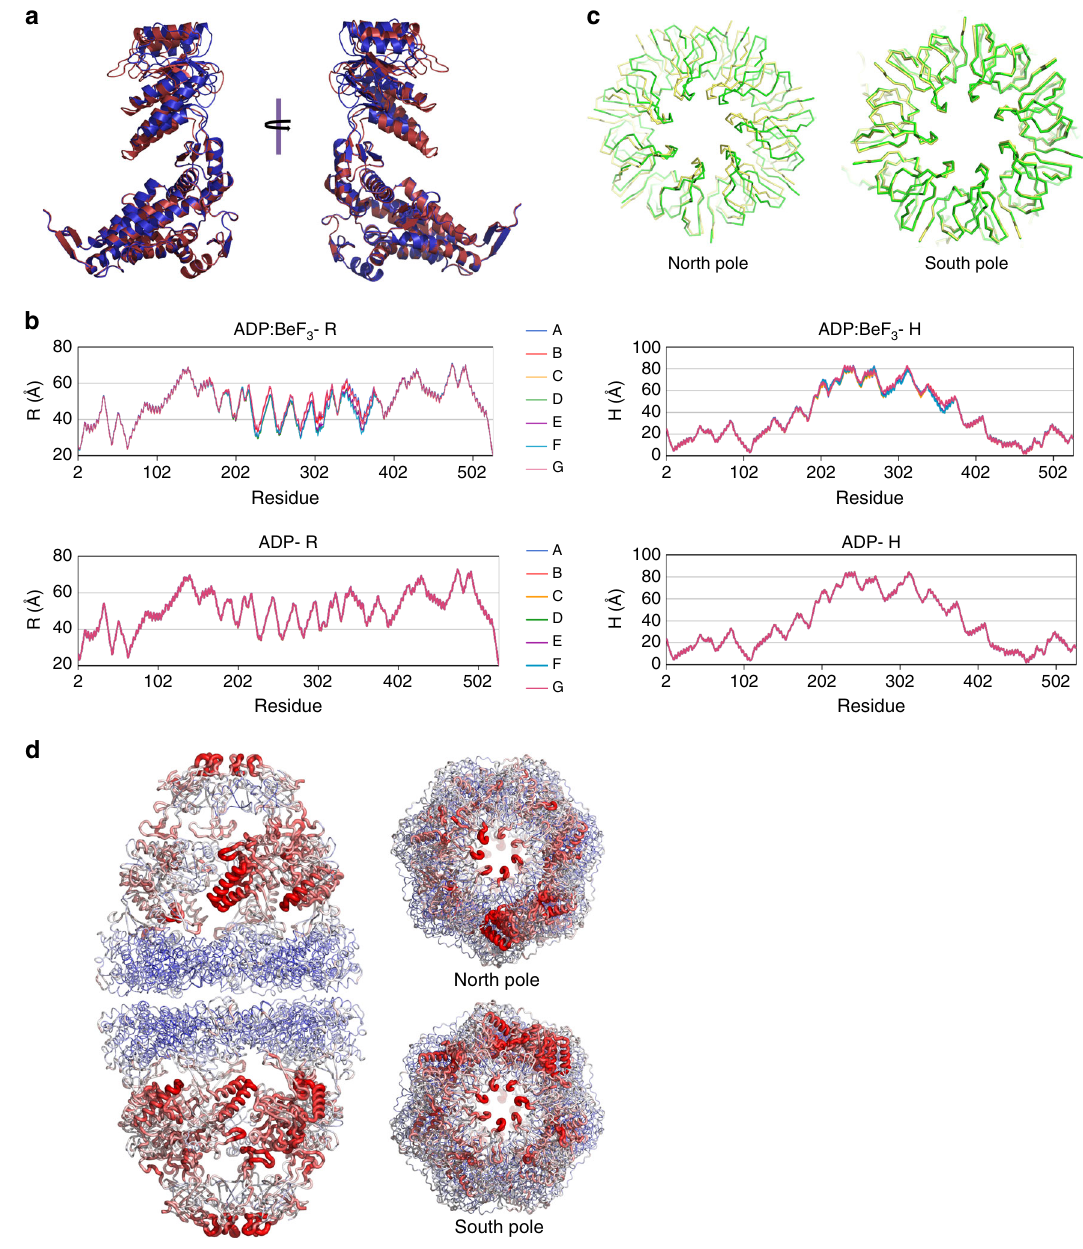
Fig. 3 Transition from the ATP ground-state mimic to ADP football. a Superposition of the two most conformationally divergent mHsp60 subunits from the ADP:BeF 3 -bound football complex shows signi fi cant backbone conformational asymmetry. The two perspectives depicted are related by 180° rotation. b The crystal structure of the ADP:BeF 3 -bound football complex and the structure of the ADP-bound football complex built from the C1 cryo-EM map were subjected to a conformational analysis using a cylindrical coordinate system previously employed to analyze the conformation of individual subunits in GroEL 36,37 . In this analysis, R is the distance between the C α of a given residue and the sevenfold symmetry axis, whereas H is de fi ned as the height of the C α of a given residue over the twofold plane of symmetry between two rings. Each trace represents one mHsp60 subunit within the same ring. From top to bottom: ADP:BeF 3 – R: radial distance to the longitudinal axis for the ADP:BeF 3 -bound football complex crystal structure; ADP – R: radial distance for the ADP-bound football complex C1 cryo-EM structure; ADP:BeF 3 – H: height from the equator of the complex for the ADP:BeF 3 -bound football complex crystal structure; ADP – H: height from the equator for the ADP-bound football complex C1 cryo-EM structure. c Top views of superposed ADP:BeF 3 and ADP footballs in green and yellow, respectively. The north equatorial domains of mHsp60 were the templates for superposition. The rotation of the mHsp10 lid is clearly seen in the north pole, while in the south pole the structures coincide with little deviation. d B-factor analysis of the ground-state ADP:BeF3 crystal structure football complex. B factors are depicted by color and thickness of the worm representation. Blue and thin indicates low values while red and thick indicates high values, respectively. Side, south, and north pole views are